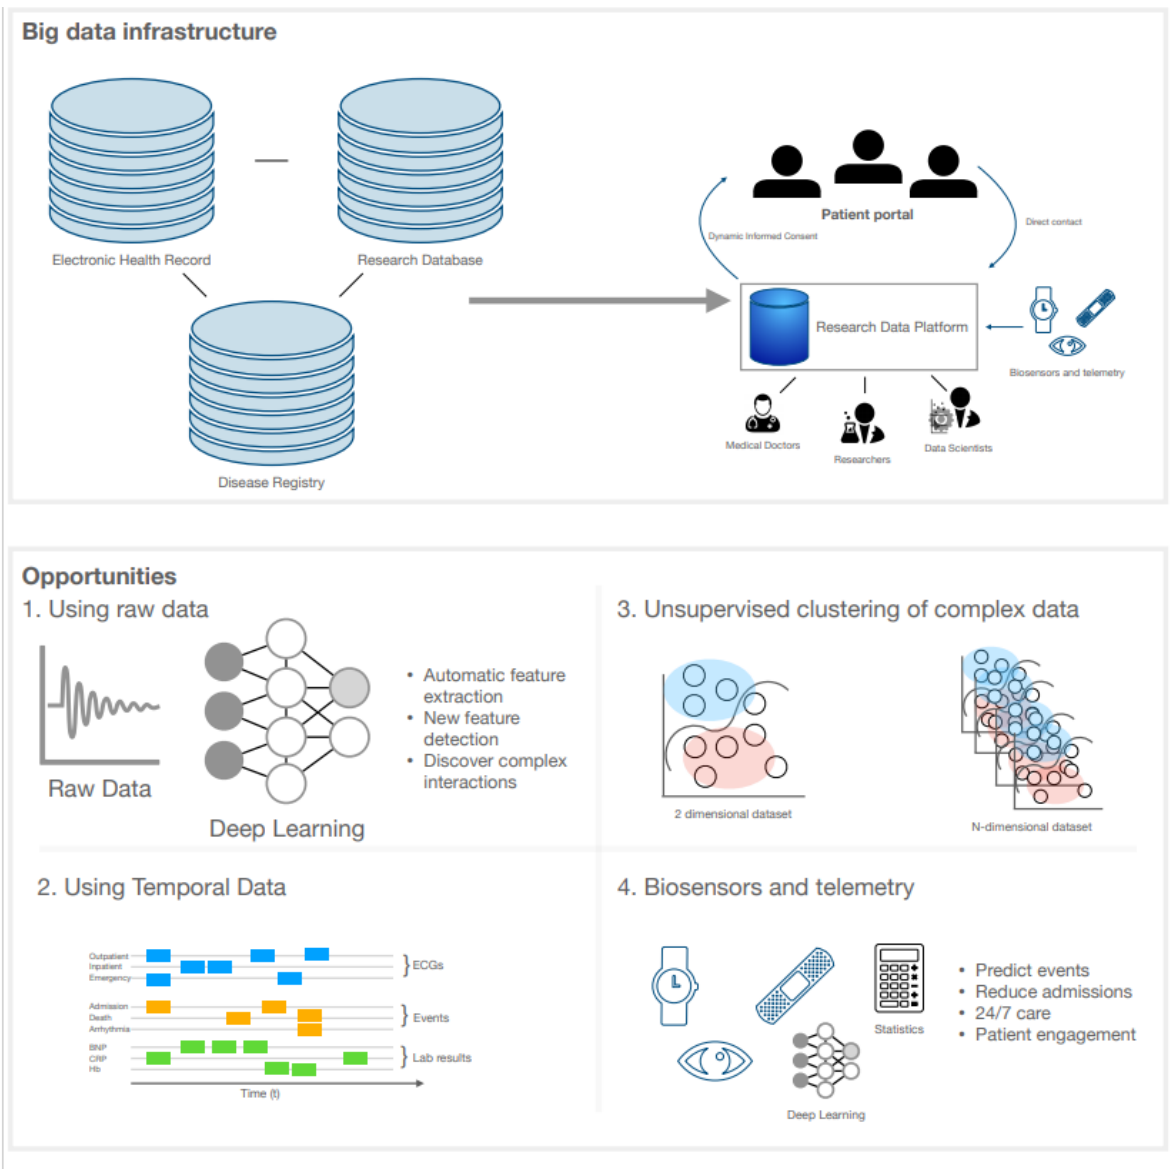
Figure 3. Big data infrastructure and opportunities using artificial intelligence, eHealth, and wearables in the management of DCM. An interoperable big data infrastructure is visualised with the possibility of research data platforms as exemplified in the text. The field is now ripe with opportunities to be explored by the eager-minded using research data platforms and using raw uninterpreted data, temporal datasets, unsupervised learning of more dimensional datasets, and the embedding of biosensors and telemetry. Abbreviations: ECG (electrocardiogram).